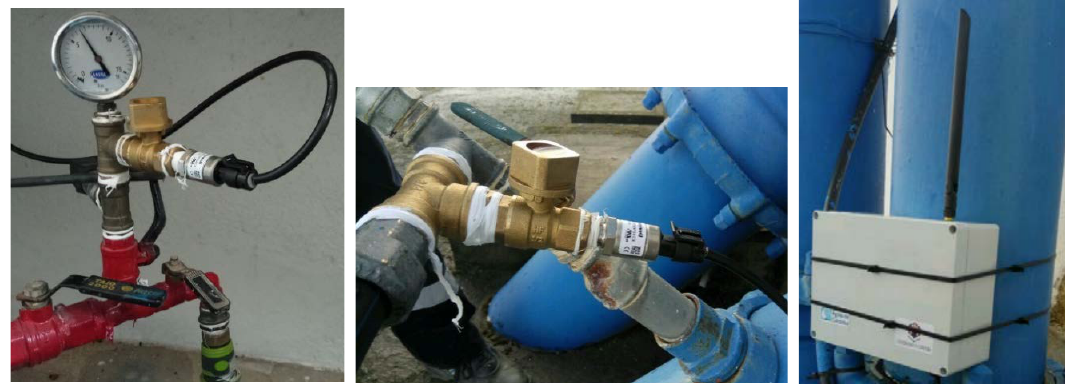
Figure 12. Prototype installation.